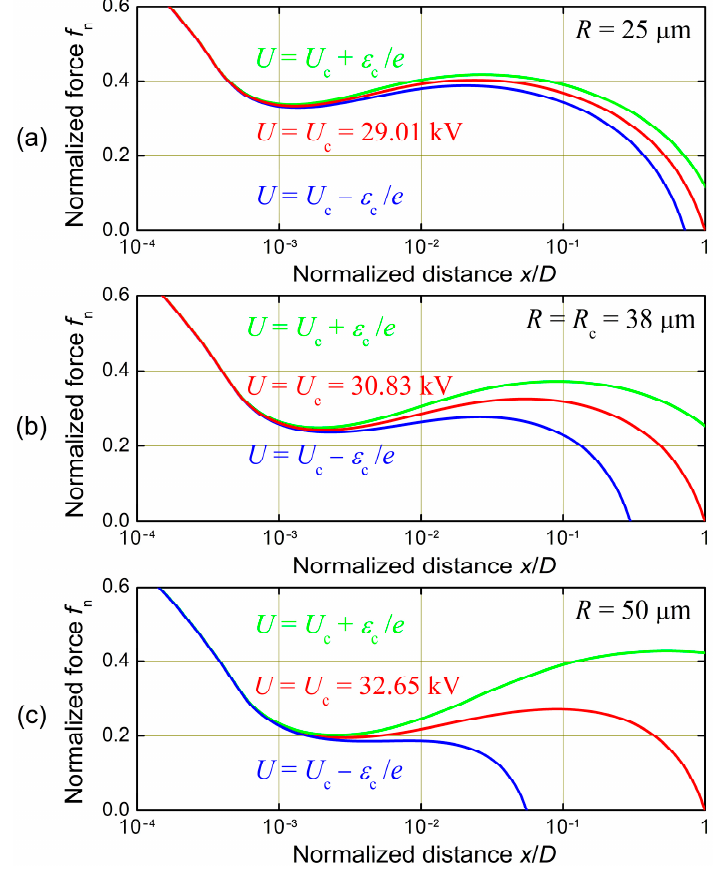
Figure 7. The numerically calculated characteristic x -dependences (on a log scale) of the normalized force f n for near-threshold voltages U c – ε c / e , U c , U c + ε c / e for R = 25 µ m ( a ), R = 38 µ m ( b ), R = 50 µ m ( c ). The corresponding threshold voltages are ~29.01, 30.83, 32.65